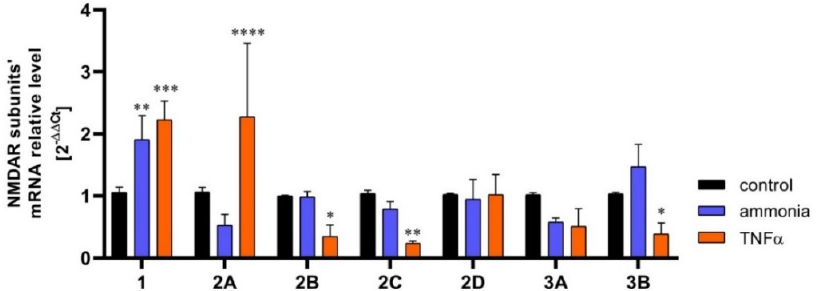
Figure 1. The content of mRNA coding for NMDAR subunits in mouse cortical astrocytes cultured in control conditions and exposed for 72 h to 5 mM ammonia or 50 ng/ml TNFα treatment. Real-time PCR procedure was exactly as in Skowrońska et al., (2019) [72]. The mRNA expression was